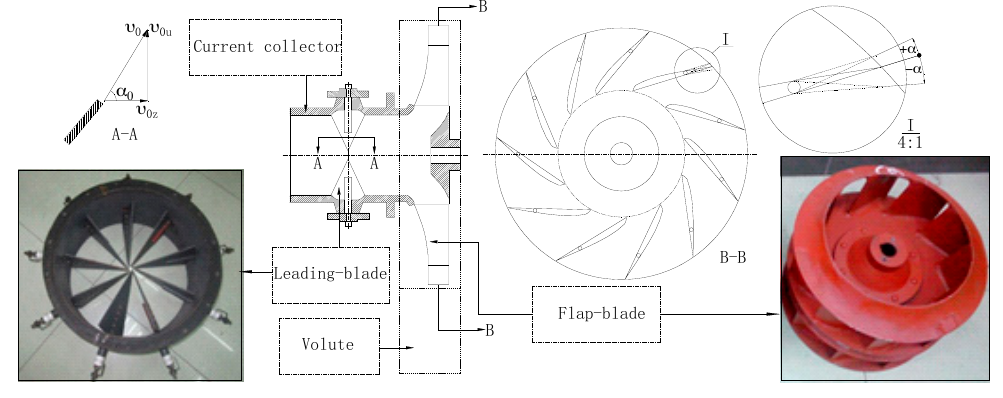
Figure 1. Adjusted principle. Table 1. Parameters of experimental centrifugal fan model.